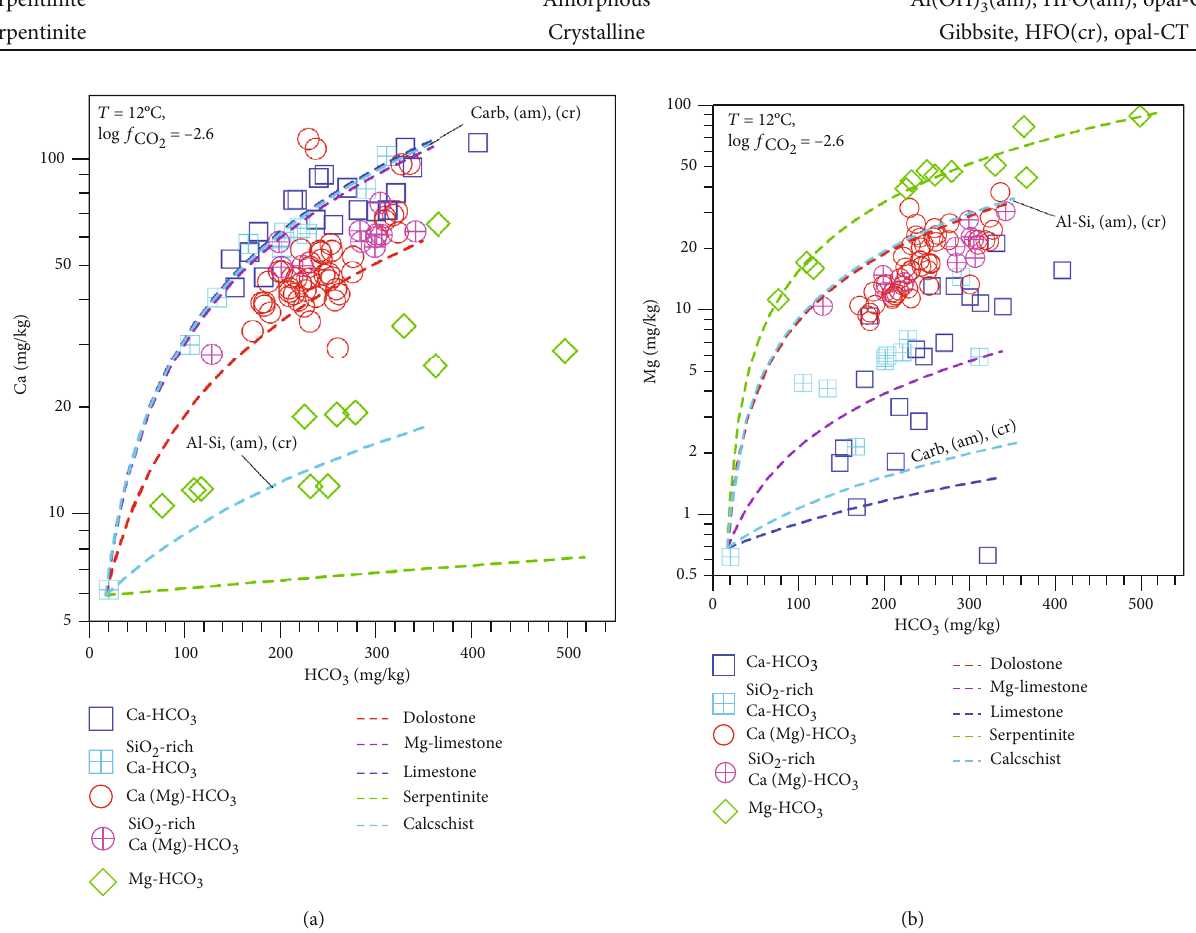
Figure 5: Correlation diagrams of alkalinity (expressed in mg HCO dissolution of di ff erent rocks (see legend) according to the simulations elaborated in this